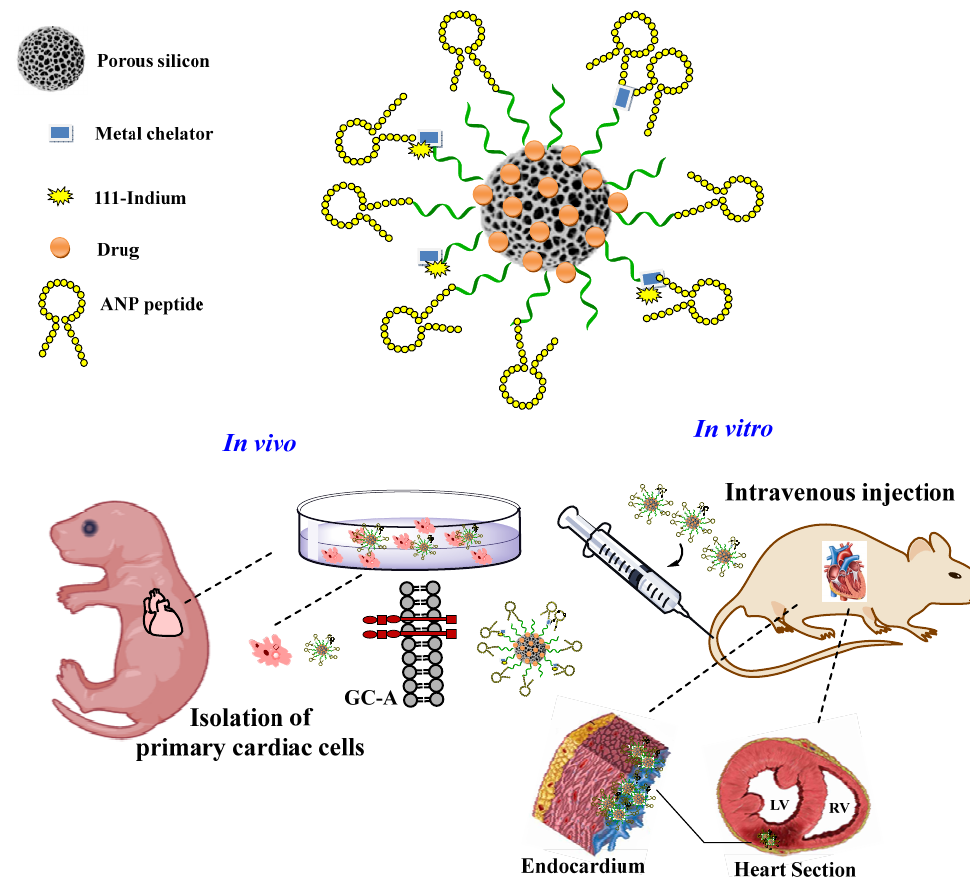
Figure 4. This schematic representation of the engineered multifunctional nanoparticle and its components, as well as an overview of the conducted in vitro and in vivo studies and the main findings of this study. Adapted from [22], Wiley-VCH, 2019.